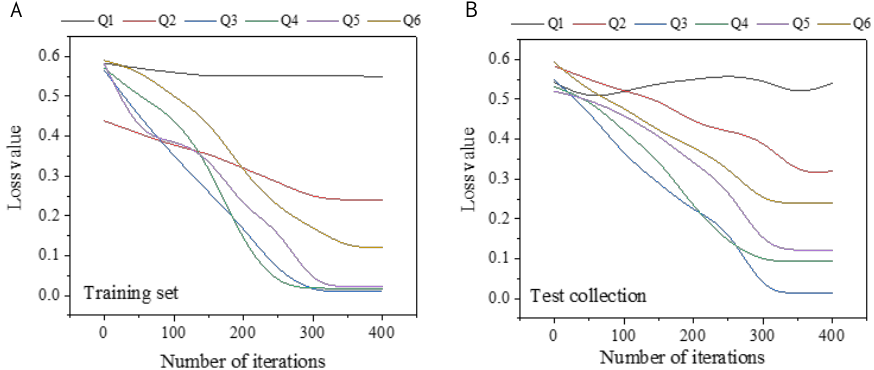
Figure 9. Feature extraction effect of different number of convolution kernels (Note: Q1 (1 × 1 convolution kernel), Q2 (3 × 3 convolution kernel), Q3 (5 × 5 convolution kernel), Q4 (7 × 7 convolution kernel), Q5 (8 × 8 convolution kernel), and Q6 (9 × 9 convolution kernel)). Figure ( A ) shows the feature extraction effect under different numbers of convolution kernels on the training set; Figure ( B ) shows the feature extraction effect under different numbers of convolution kernels on the test set.